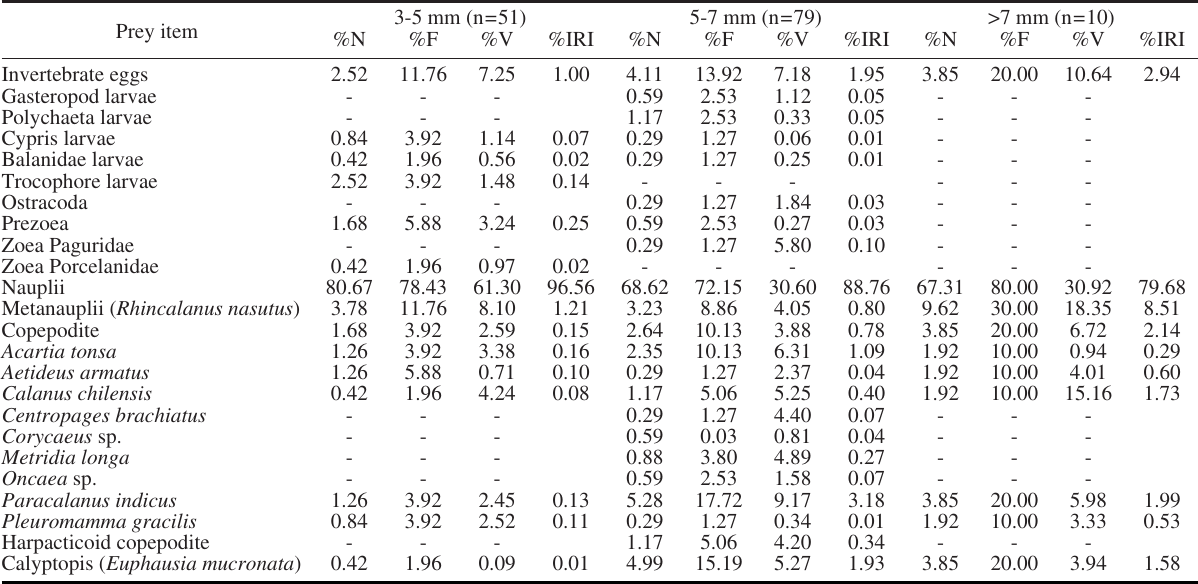
Table 3. – Prey composition of sandperch Pinguipes chilensis larvae off central Chile. %N corresponds to the percent of the total number of prey items, %F to the percent frequency of the occurrence of a diet among larvae with food in their guts, and %V to the percent of the total volume of prey items. %IRI corresponds to the index of relative importance as a